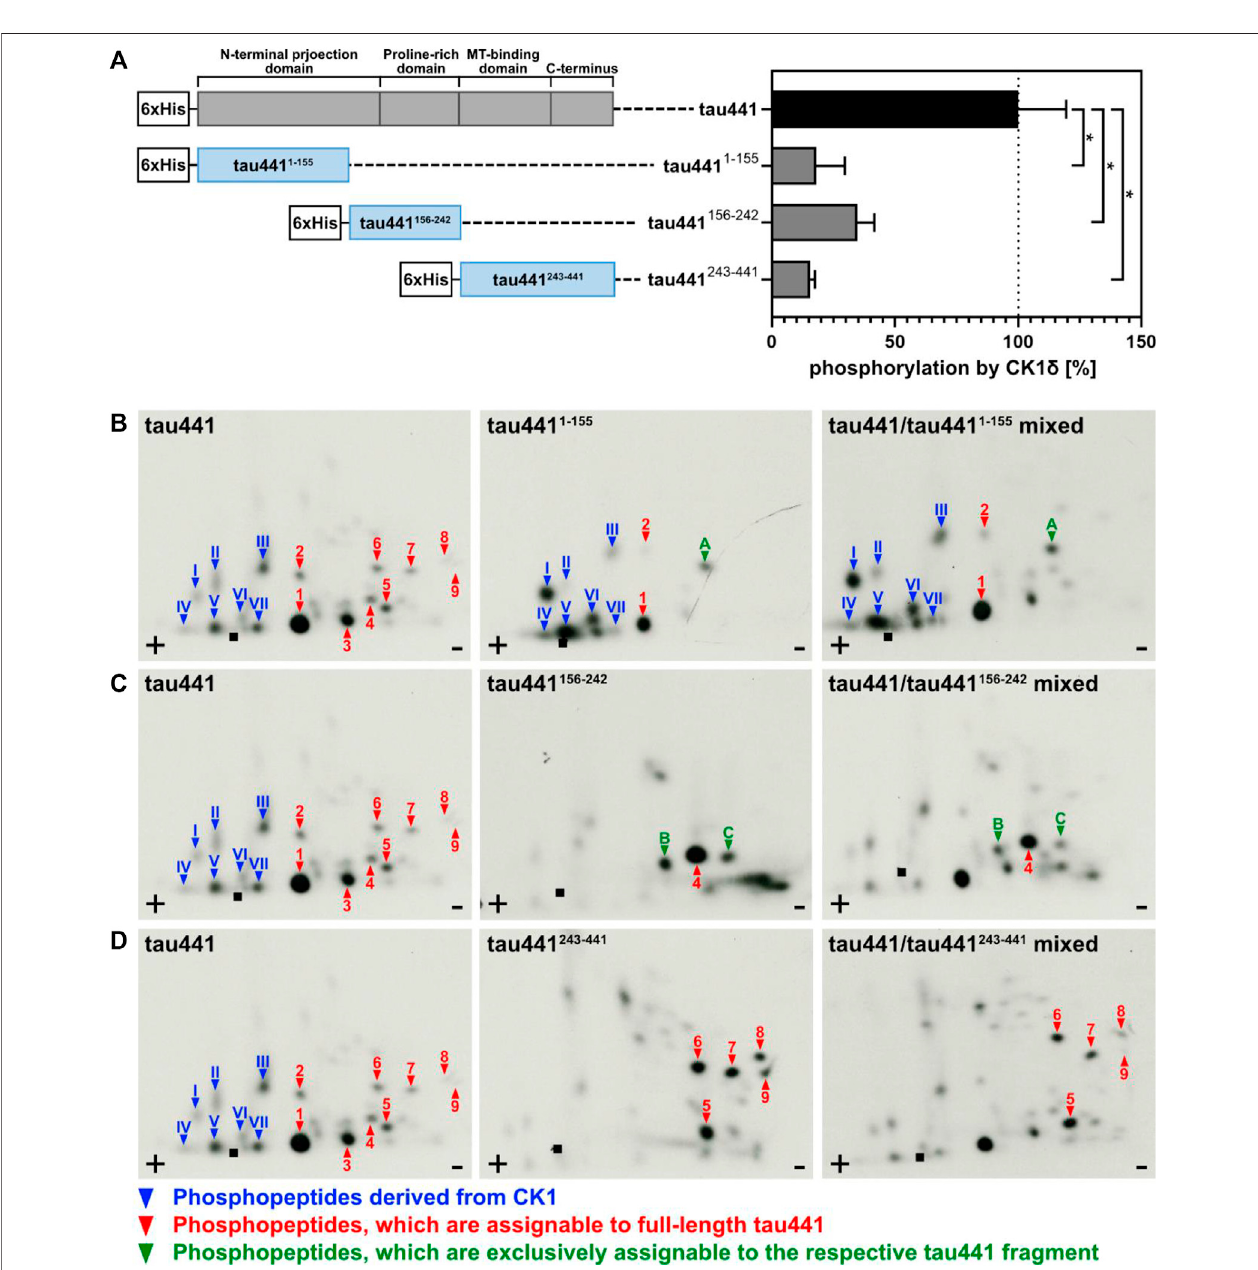
FIGURE 3 | Tau441 and tau441 fragments are phosphorylated by CK1 δ in vitro . Tau441 as well as tau441 1-155 , tau441 156-242 and tau441 243-441 fragments were phosphorylated by CK1 δ in vitro . (A) After separation of phosphorylated proteins by SDS-PAGE followed by Coomassie staining, determination of phosphate incorporation into the different tau proteins was performed by Cerenkov counting. Data is shown as mean values of the experiments performed in triplicates and error barsrepresentthestandarddeviation.Datawasnormalizedtofull-lengthtau441.Statisticalsigni fi cancewastestedusingthenonparametricMann-WhitneyUtest. * indicates p ≤ 0.05. MT: microtubule. Full-length tau441 as well as (B) tau441 1-155 , (C) tau441 156-242 and (D) tau441 243-441 were phosphorylated by CK1 δ in vitro , processed and analyzed by two-dimensional phosphopeptide analysis. Arabic numerals indicate major phosphorylated peptides, which can be assigned to full-length tau441.Phosphopeptides,thatareexclusivelyphosphorylatedintherespectivetau441fragmentareindicatedwithletters.Romannumeralsindicatedphosphopeptides that correspond to autophosphorylated CK1 δ . ■ : loading point of samples, +: anode, − : cathode.